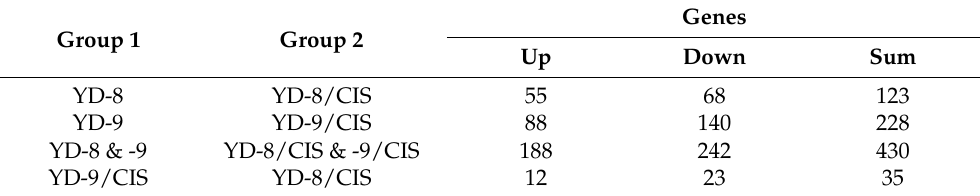
Each comparison is run between the other paired cell lines. up = upregulated; down = downregulated; sum = up- and